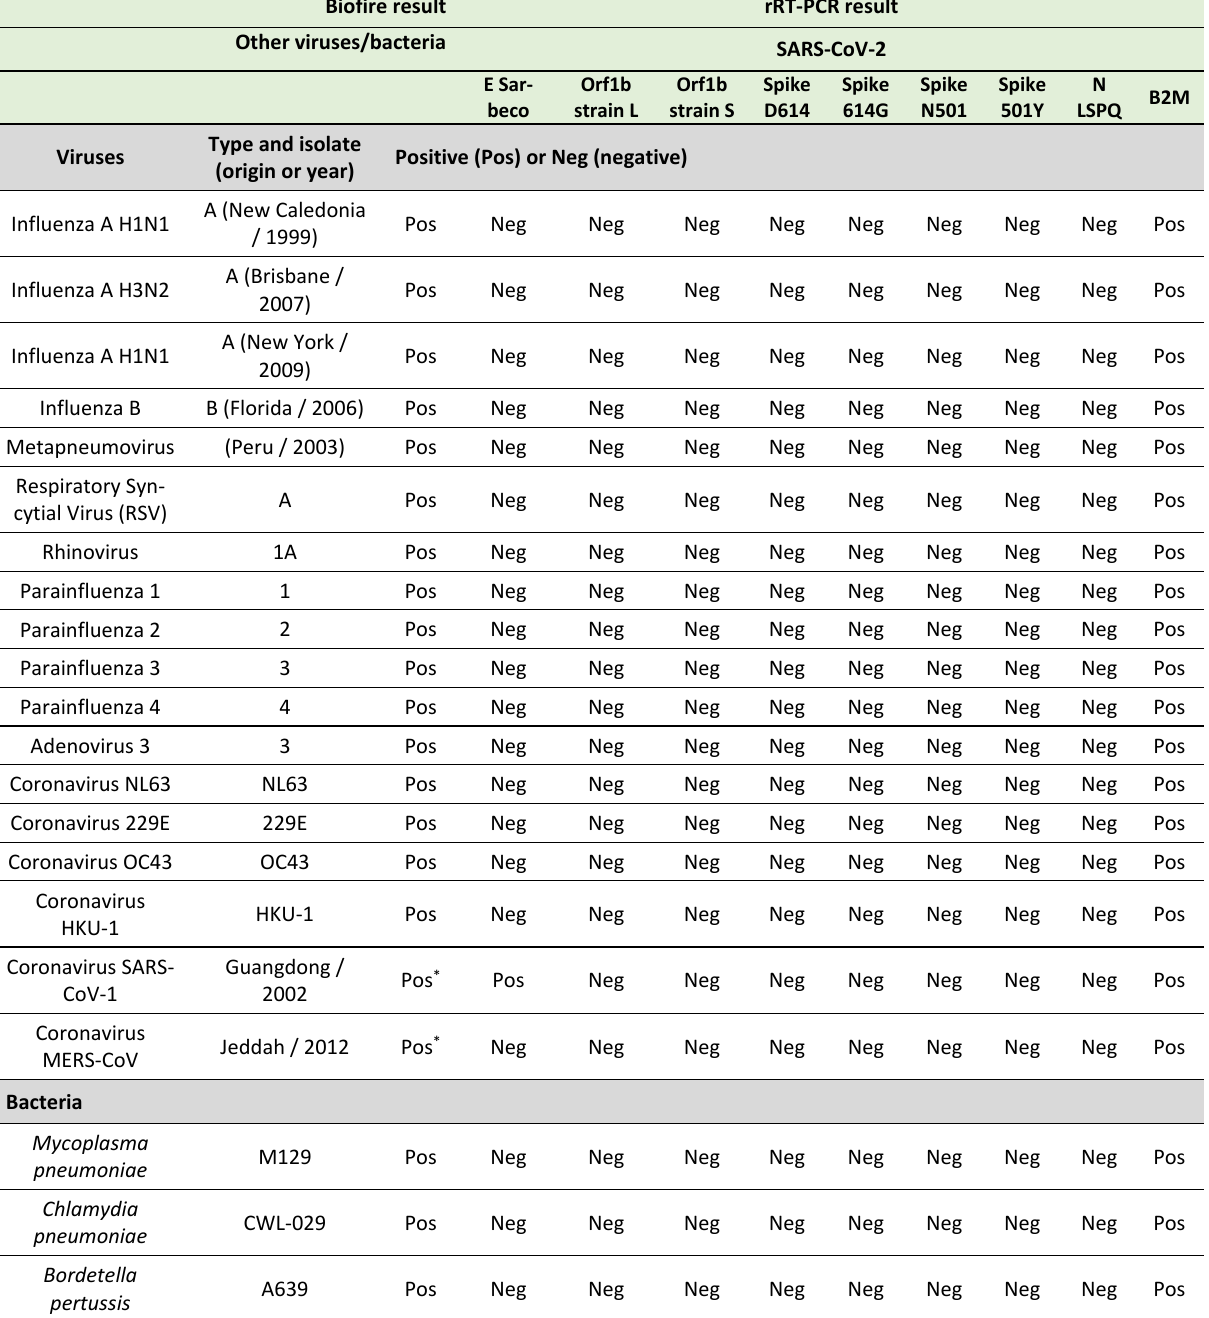
TABLE 4. Specificities of fluorogenic SARS-CoV-2 probes with a number of other viruses and